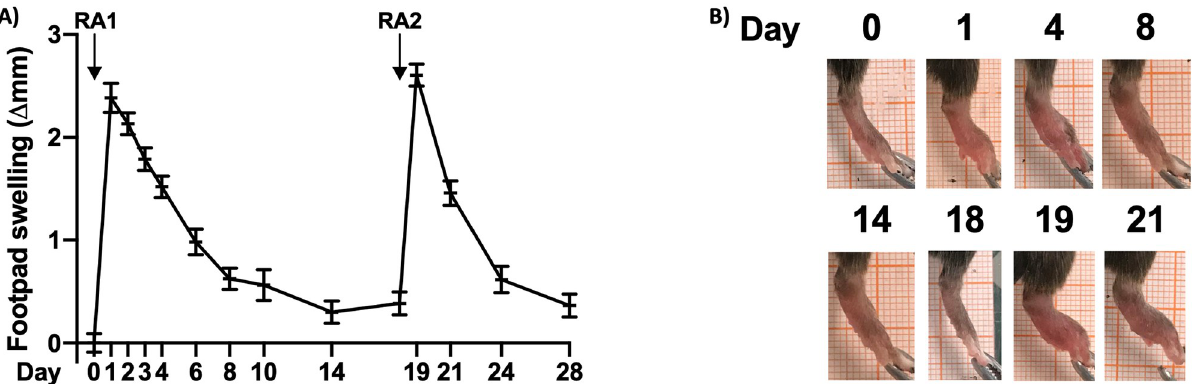
Fig 1. Assessment of footpad swelling in the DTHA model. Panel A : Footpad swelling from day 0 through day 28 after arthritis induction by s.c. injection of mBSA (RA1). At day 15, mice received an additional i.v. injection of anti-collagen II antibodies before an additional injection with mBSA (day 18, RA2), re-establishing arthritis. Figure displays increase of sagittal diameter in mm from baseline. Data is shown as mean ± SEM (n = 25). mBSA, methylated bovine serum albumin. Panel B : Representative photographs displaying temporal paw swelling.